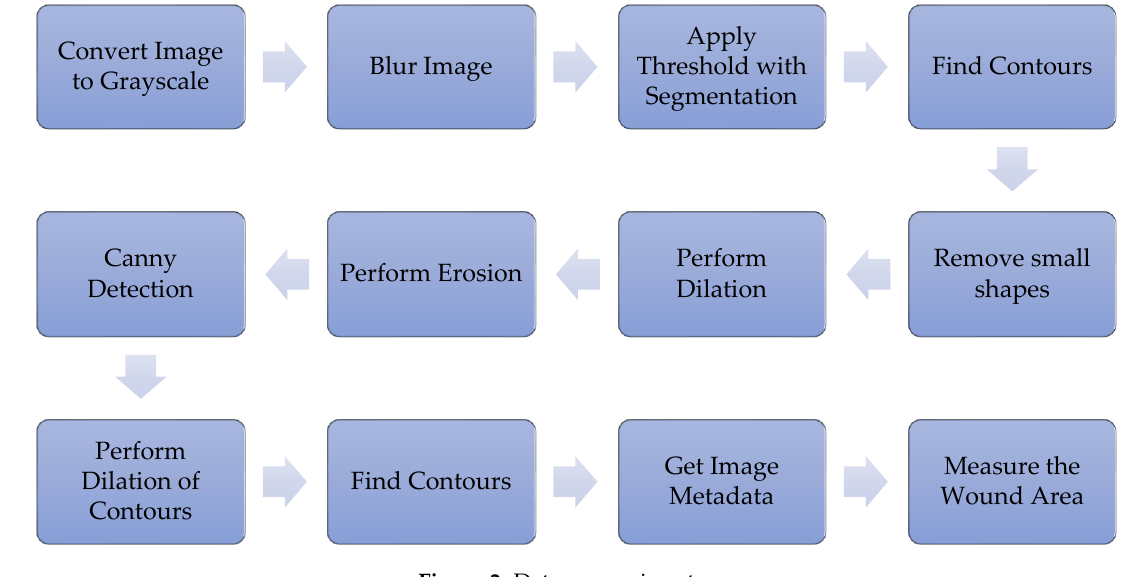
Figure 2. Data processing steps.